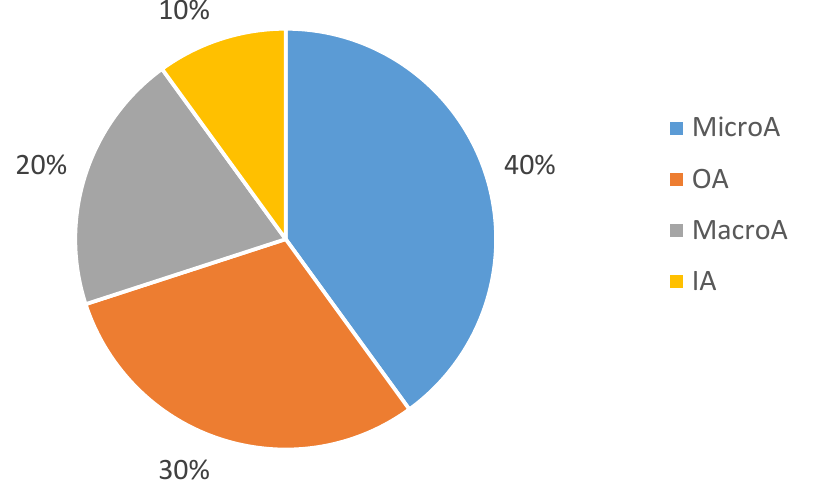
Figure 3. Distribution of approaches to inputs and outputs on the commercialization efficiency of conventional